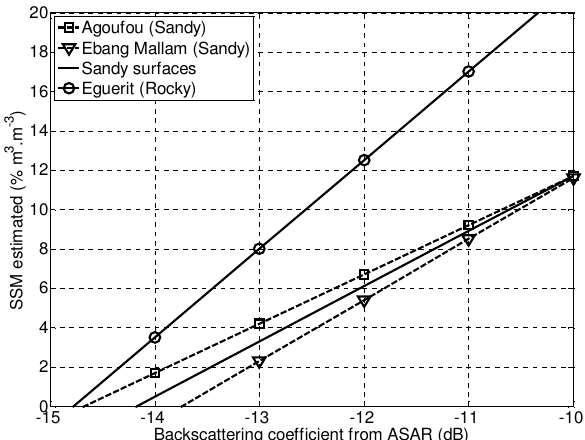
Fig. 7. Surface Soil Moisture – Backscattering coefficient regres- sion functions estimated over the two sandy sites and the rocky Fig 7: Surface Soil Moisture - Backscattering coefficient regression functions estimated over 665 site. The final regression function used over sandy surfaces is also the two sandy sites and the rocky site. The final regression function used over sandy 666 surfaces is also plotted. 667 668